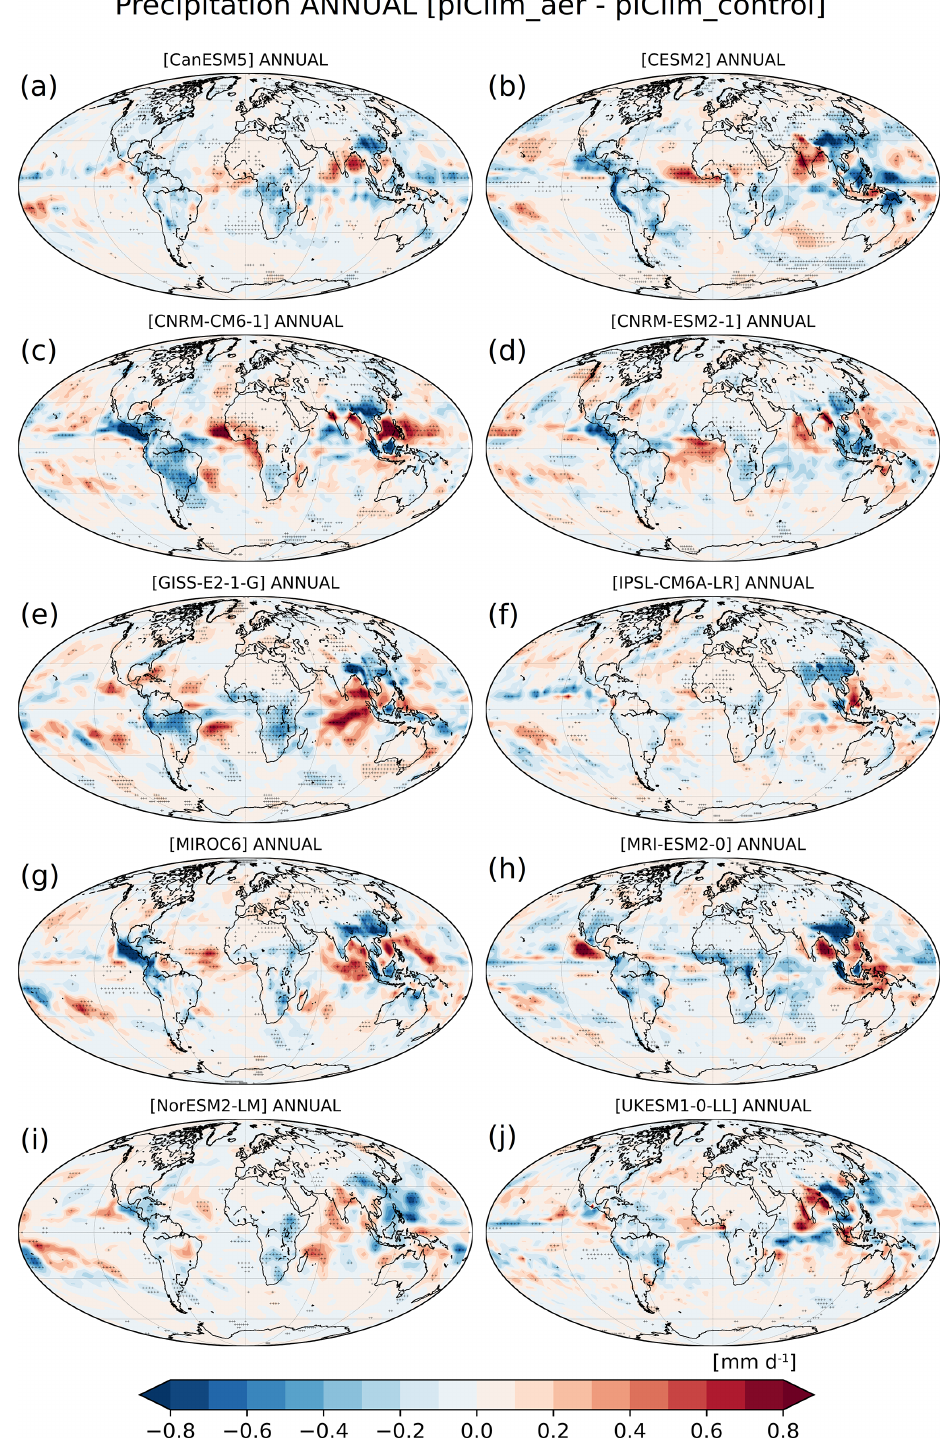
Figure 10. Annual differences between piClim-aer and piClim-control in precipitation (mmd − 1 ) for each one of the models used for the ensemble. The dot shading indicates areas in which the differences are statistically significant at the 95% confidence level.